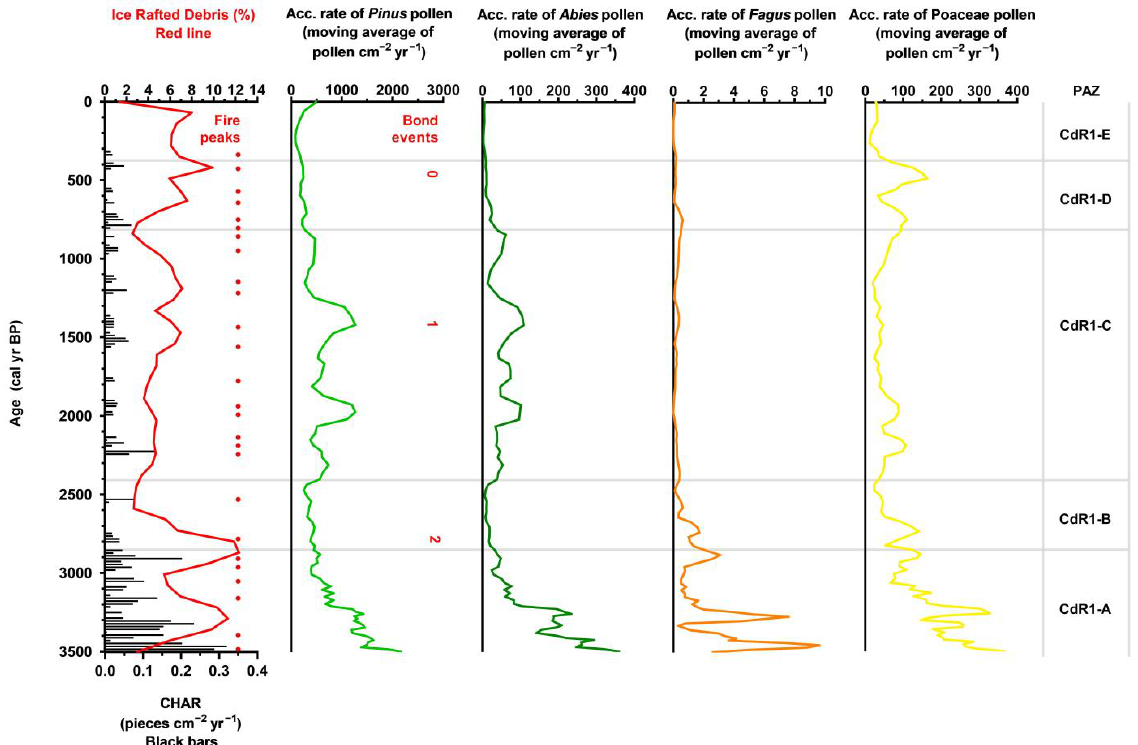
Figure 7. Sedimentary macrocharcoals (CHAR and fire peaks), IRD percentage, Bond events, and Pinus , Abies , Fagus , and Poaceae moving average pollen along the PAZ.